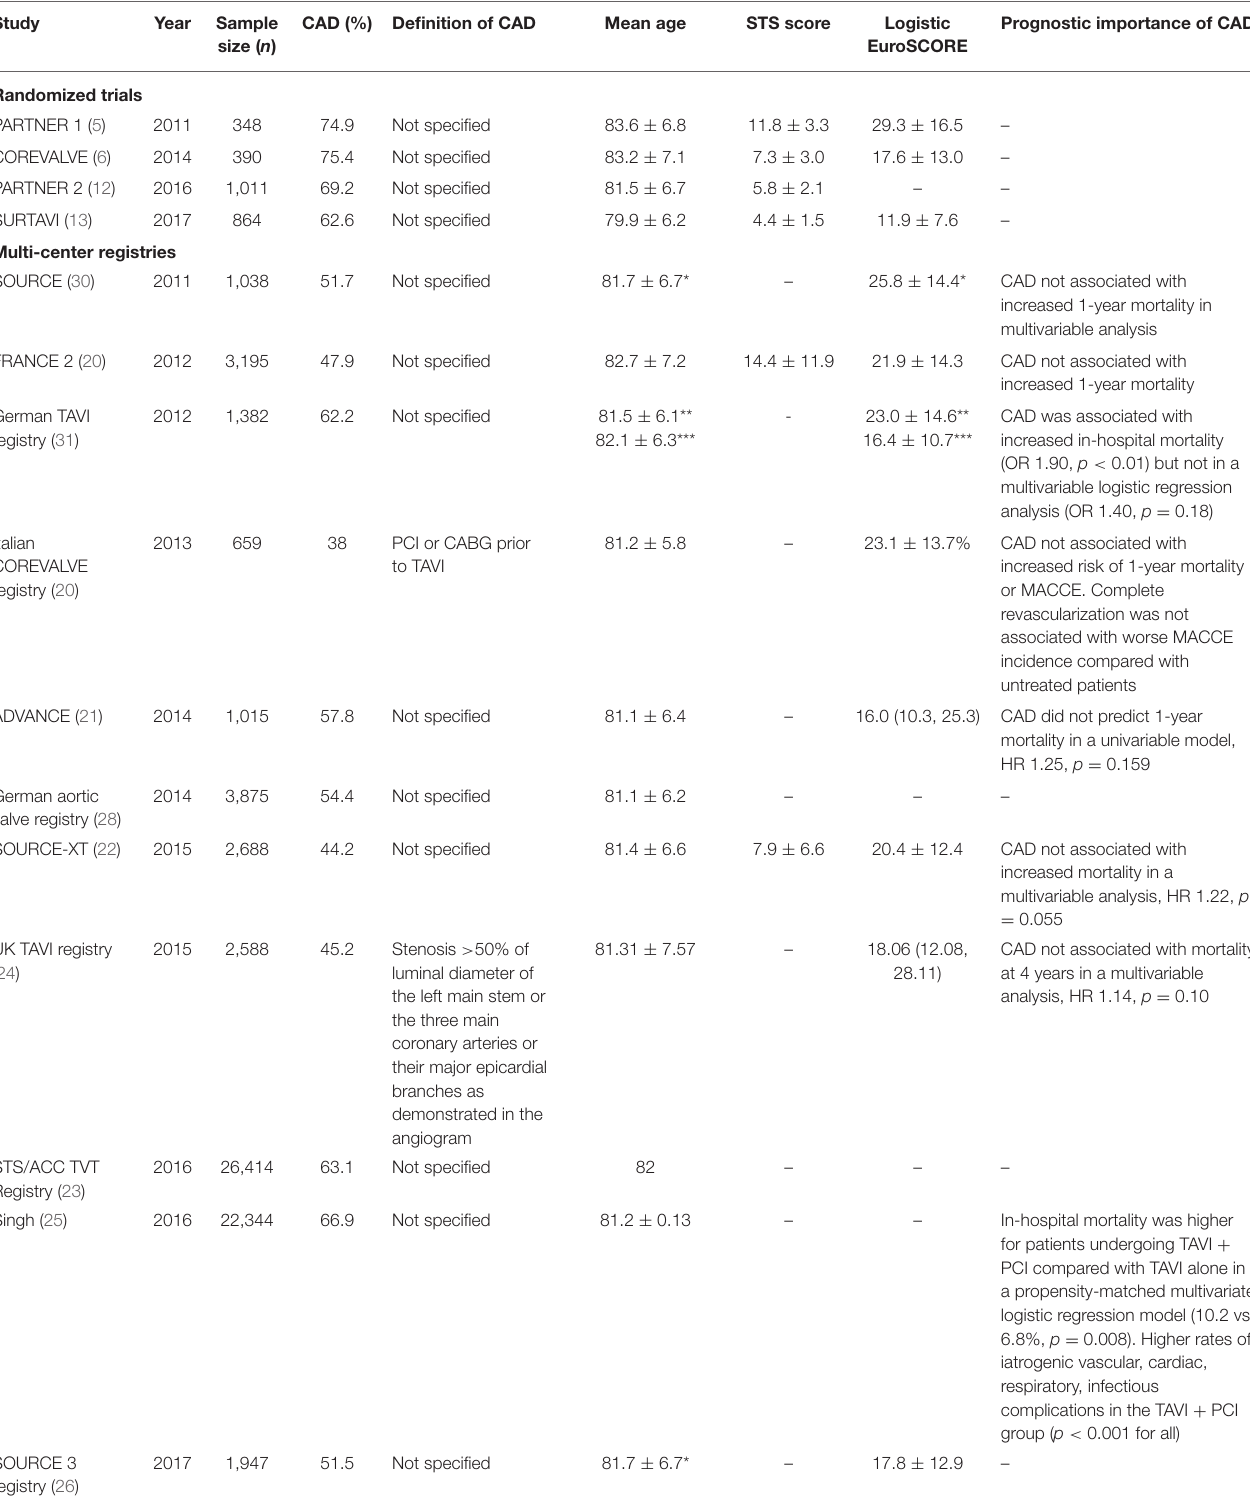
TABLE 1 | Prevalence, definition, and importance of CAD in TAVI reported in randomized trials and real-world multi-center registries.